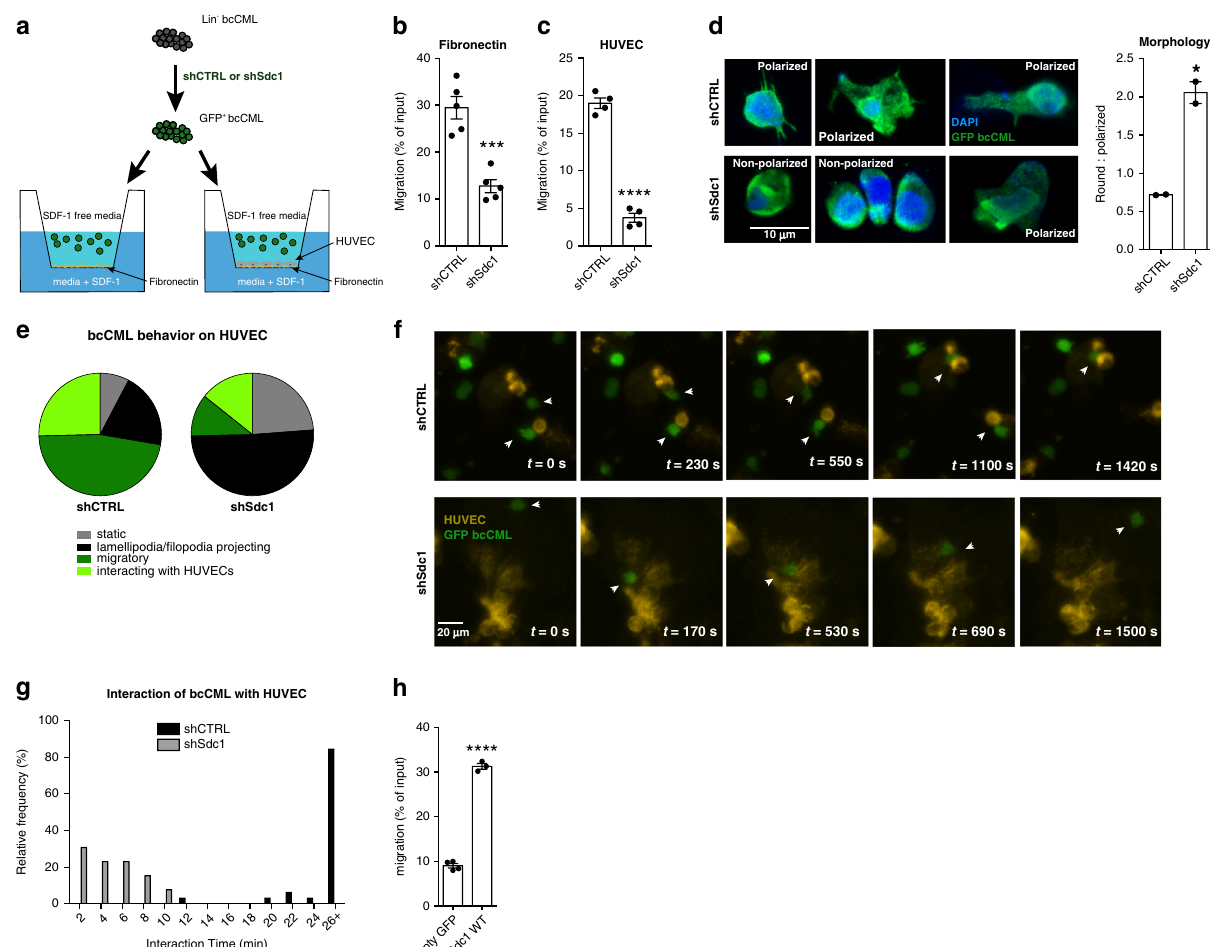
Fig. 7 Syndecan-1 mediates cell migration. a Schematic of transwell migration assay across either FN or FN + HUVEC monolayer. b SDF-1 induced migration of shCTRL or shSdc1 bcCML cells across fi bronectin-coated transwell fi lters. *** P = 0.0003 ( n = 3 technical replicates, representative of four biological replicates). c SDF-1 induced migration of shCTRL or shSdc1 bcCML cells across HUVEC monolayers seeded on fi bronectin-coated transwell fi lters. **** P < 0.0001 ( n = 4 technical replicates, representative of two biological replicates). d Representative immuno fl uorescence of shCTRL or shSdc1 bcCML after 4 h incubation on fi bronectin-coated transwell fi lters; green = shRNA vector, blue = DAPI. Quanti fi cation of polarized and non-polarized shCTRL or shSdc1 cells. * P = 0.01 ( n = 3 biological replicates, >30 cells per condition). e – g Characterization of bcCML behavior when interacting with HUVECs on fi bronectin-coated polyacrylamide gels (8 kPa). e Cell behaviors are strati fi ed as: completely immobile (gray = static); immobile, but sensing its surroundings by extending lamellipodia and or fi lopodia (black = lamellipodia/ fi liopodia projecting); migratory, but not interacting with HUVECs (dark green = migratory); migratory and sustaining prolonged interactions with HUVECs (light green = interacting with HUVECs) ( n > 10 cells per fi eld of view for four fi elds across two independent experiments). f Representative time-lapse images demonstrating bcCML cell behavior in proximity to HUVECs on fi bronectin-coated polyacrylamide gels (See also Supplementary Movies 4 and 5). g Duration of interactions between bcCML and HUVECs. ( n = 33 events for shCTRL and n = 13 events for shSdc1). h SDF-1 induced migration of Sdc1 − / − bcCML cells with empty control or wild-type Sdc1 ectopically expressed across HUVEC monolayers seeded on fi bronectin-coated transwell fi lters. **** P < 0.0001 ( n = 4 technical replicates). Two-tailed unpaired Student ’ s t- tests were used to determine statistical signi fi cance. Source data are provided as a Source Data